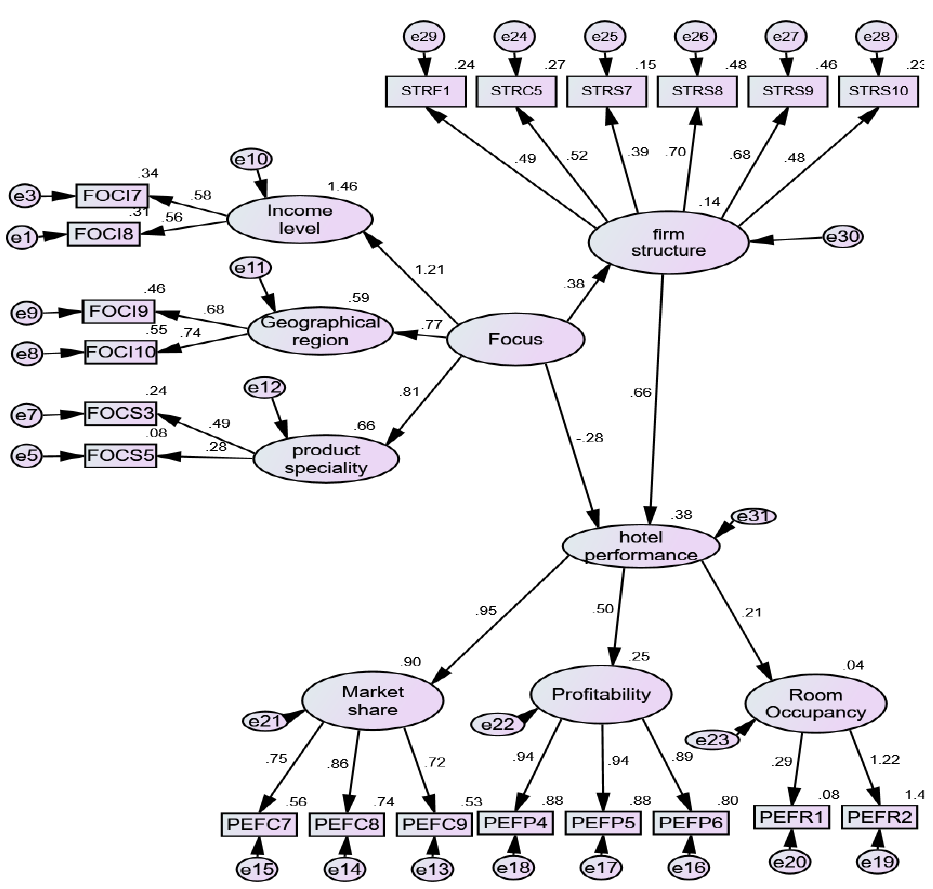
Figure 3: Structural equation model of influence of focus strategy-firm structure fit on hotel performance R 2 obtained from the SEM model in figure 3 explains the degree of variance by focus strategy-firm structure fit on hotel performance. Focus strategy explained 14% (R 2 = .14) of the variance in firm structure. Further, the model shows that focus strategy-firm structure fit explained 38% (R 2 = .38) of the variance in hotel performance. The remaining 62% was explained by other factors not included in this study.